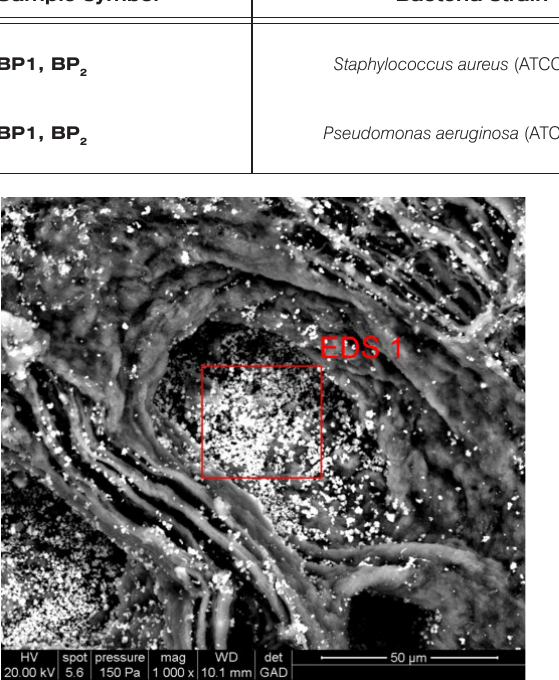
Table 5. Testing the biocidal effect of the sheepskins treated with AgNPs against Staphylococcus aureus (ATCC 6538) and Pseudomonas aeruginosa (ATCC 9027). Sample symbol